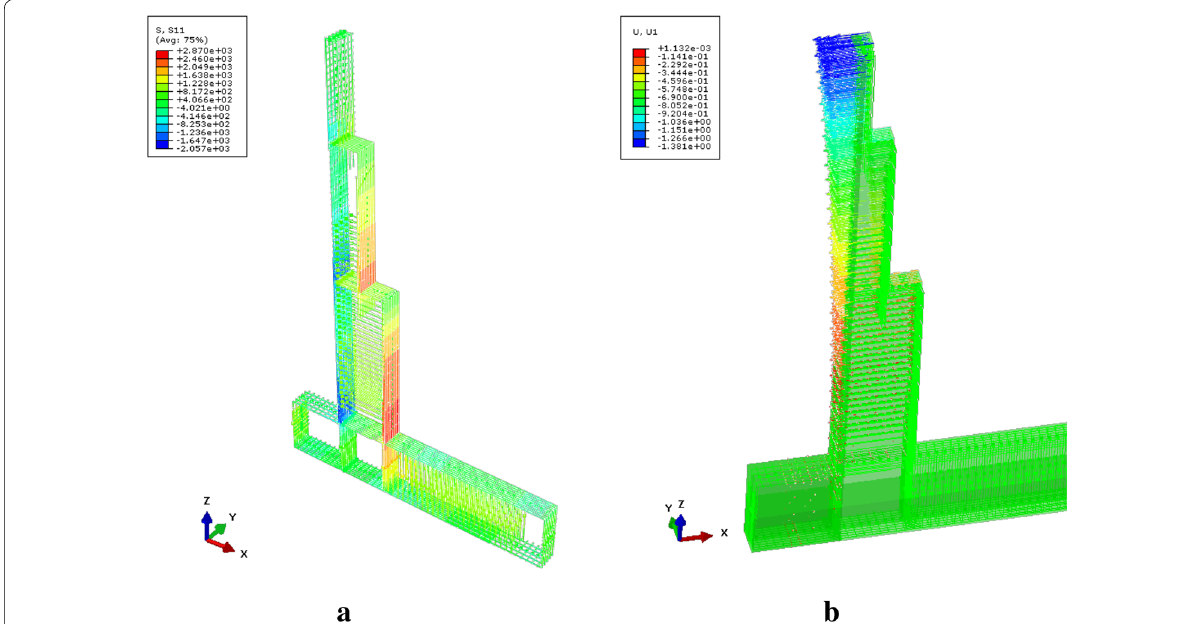
Fig. 19 Thermo‑mechanical response of the retaining wall at 28 days: a stress field in the rebar (in N/cm 2 ), and b horizontal displacement (in